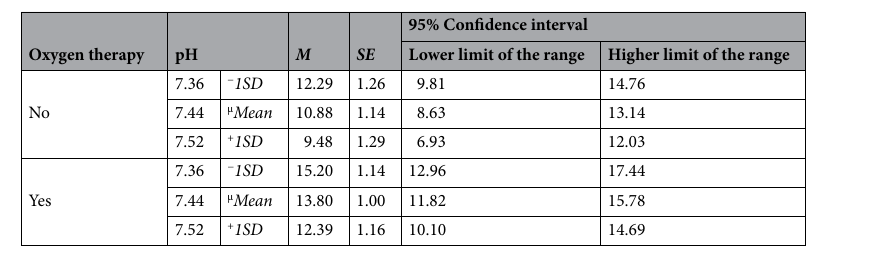
Oxygen therapy pH M SE